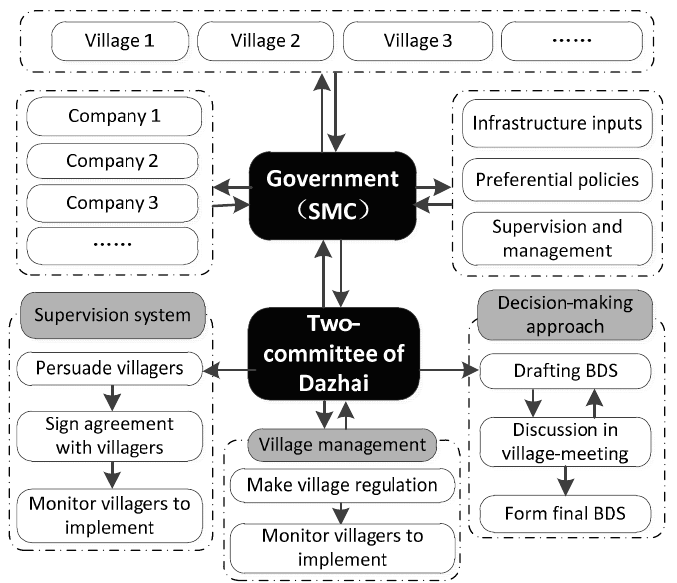
Figure 8. Diagram of multi-stakeholder participation mechanism of Dazhai.